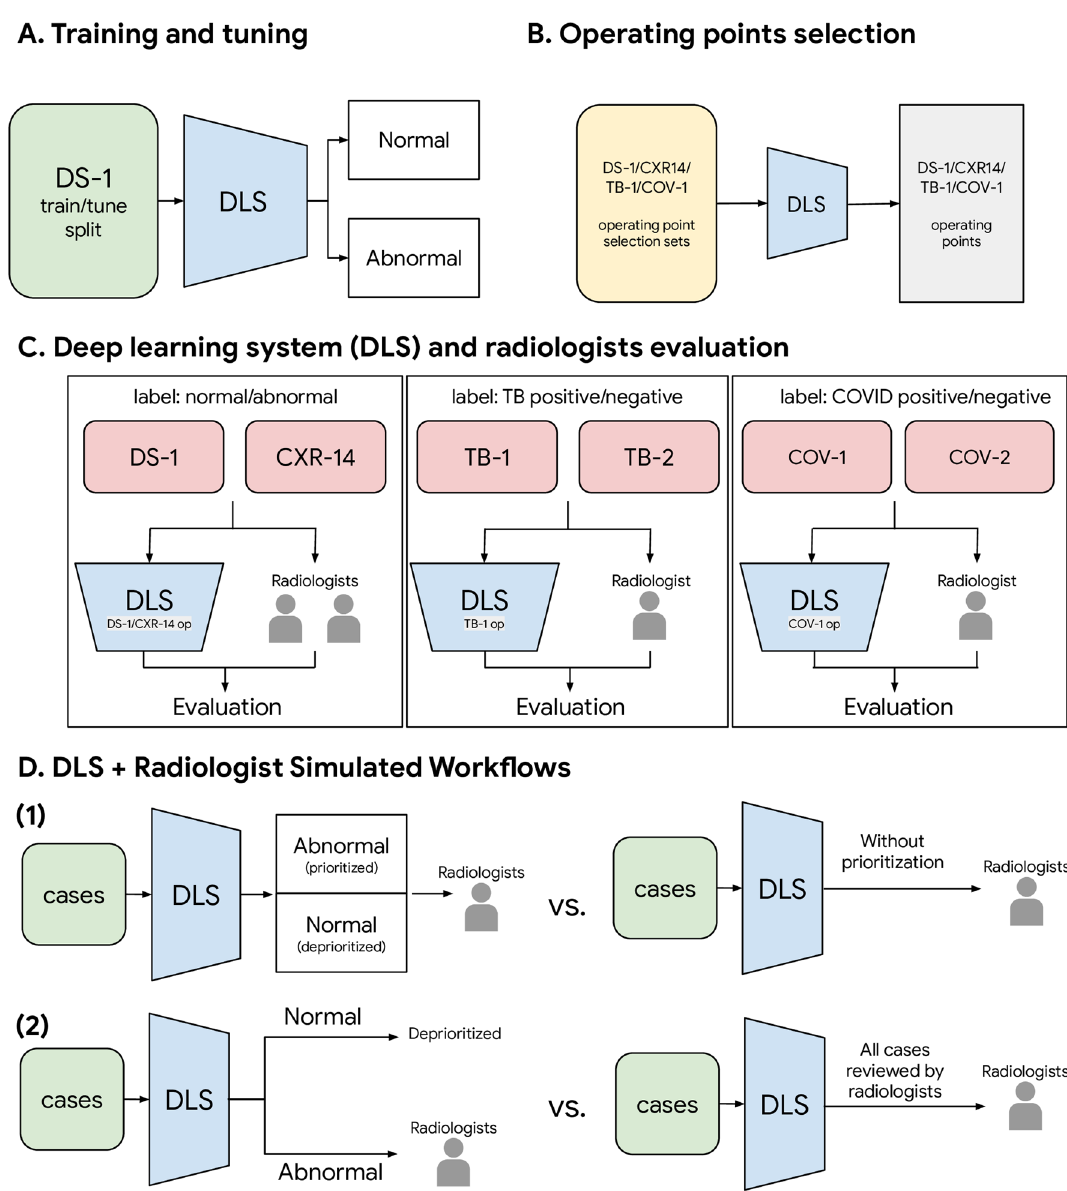
Figure 1. Schematic of the study design, including ( A ) training and tuning, ( B ) operating points selection, ( C ) evaluation on the deep learning system and radiologists, and ( D ) two simulated DLS-assisted workflows. DS-1, CXR-14, TB-1, TB-2, COV-1, COV-2 are abbreviations of the datasets, please see Table 1 and Supplementary Table 1 for Performance in the setting of unseen diseases. The DLS was next evaluated on two diseases that it had not been trained to detect (TB and COVID-19) across four disease-specific datasets: TB-1, TB-2, COV-1, and COV-2. In these analyses, the DLS was evaluated against the reference standard for each specific disease (TB or COVID, respectively, see “Labels” section in “Methods”). For TB (where the percentages of disease-positive images were 52% and 40% in TB-1 and TB-2; Table 1), the AUCs were 0.95 (95% CI 0.93–0.97) in TB-1 and 0.97 (95% CI 0.94–0.99) in TB-2 (Table 2, Fig. 2B). At the high-sensitivity operating point, the DLS predicted 43.1% of TB-1 and 38.3% of TB-2 as negative, with NPVs of 0.88 and 0.98, respectively (Table 2A). The NPVs and PPVs across different operating points are also plotted in Fig. 3. However, CXRs that were labeled (TB) negative could nonetheless contain other abnormalities (see “Labels” section in “Methods”). Hence PPVs (Table 2A,B) need to be interpreted with the context that low PPVs for identifying TB-positive radiographs as abnormal do not neces- sarily reflect the PPV for correctly identifying images with other findings in those datasets (see “Distributional shift between datasets” below). The latter results (DLS performance for identifying abnormalities in TB-1 and TB-2) are presented in Supplementary Fig. 6, with AUCs between 0.91 and 0.93. Every image in TB1 and TB2 was also annotated as normal or abnormal by one radiologist from a cohort of 8 consultant radiologists from India. The radiologist NPVs were 0.74 and 0.88 and their PPVs were 0.93 and 0.93 on